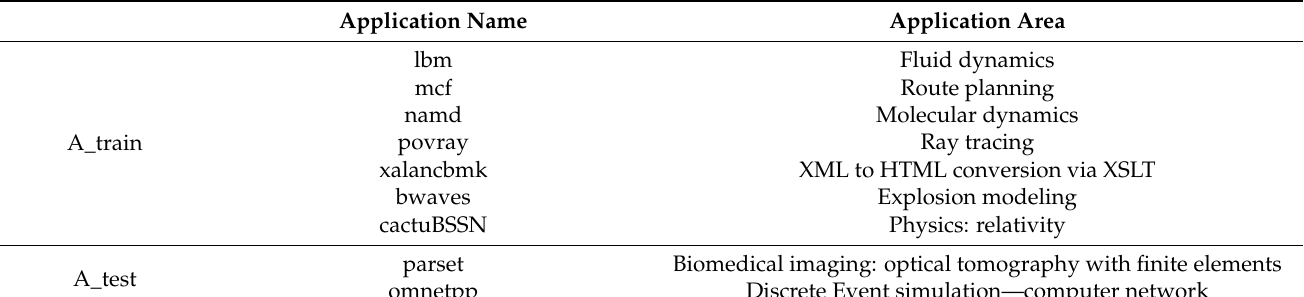
Table 2. Benchmark applications we select from SPEC